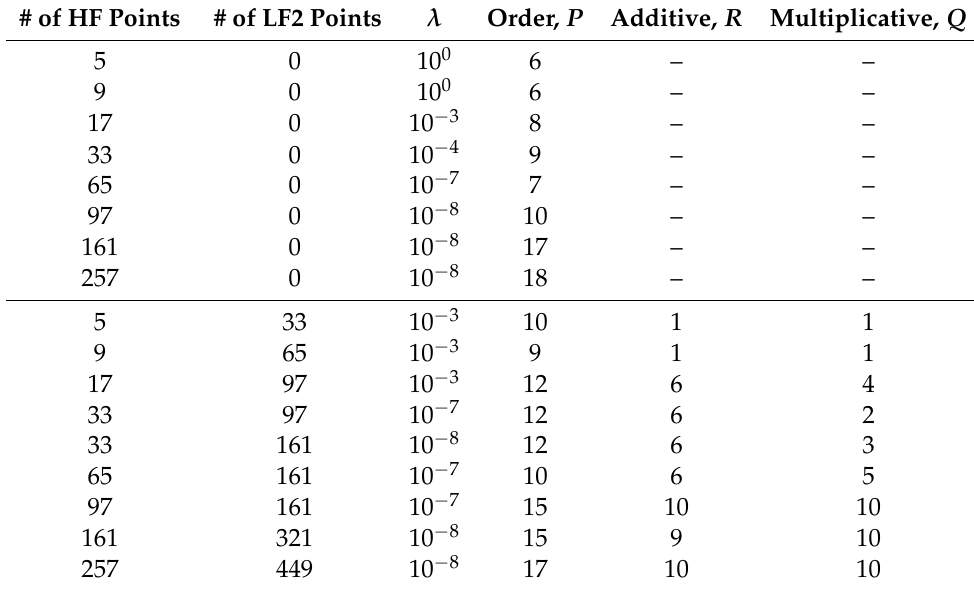
Table 4. Best order and λ values for the two-dimensional Rastrigin function using MF SPCE. # of HF